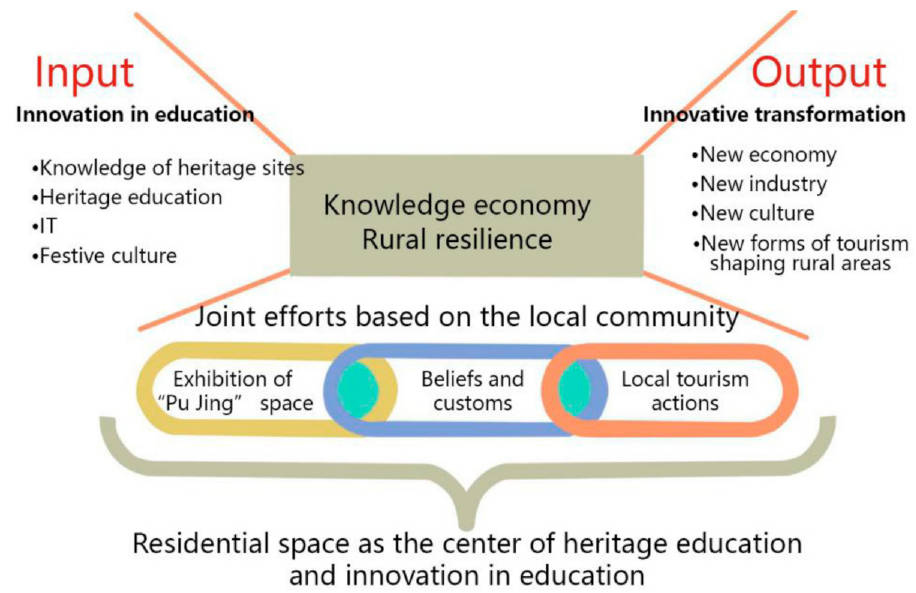
Figure 5. The development framework of rural resilience under a knowledge economy (drawn by Jing